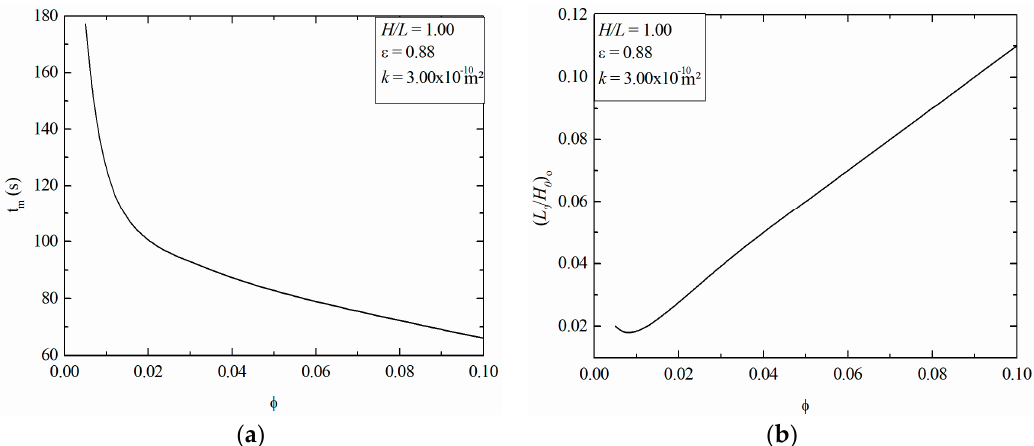
Figure 6. Effect of empty I-shaped channel area fraction ( ϕ ) over: ( a ) once minimized filling time ( t m ), Figure 6. E ff ect of empty I-shaped channel area fraction ( φ ) over: ( a ) once minimized filling time ( t m ), ( b ) once optimized L 0 / H 0 ratio, ( L 0 / H 0 ) o . ( b ) once optimized L 0 / H 0 ratio, ( L 0 / H 0 ) o